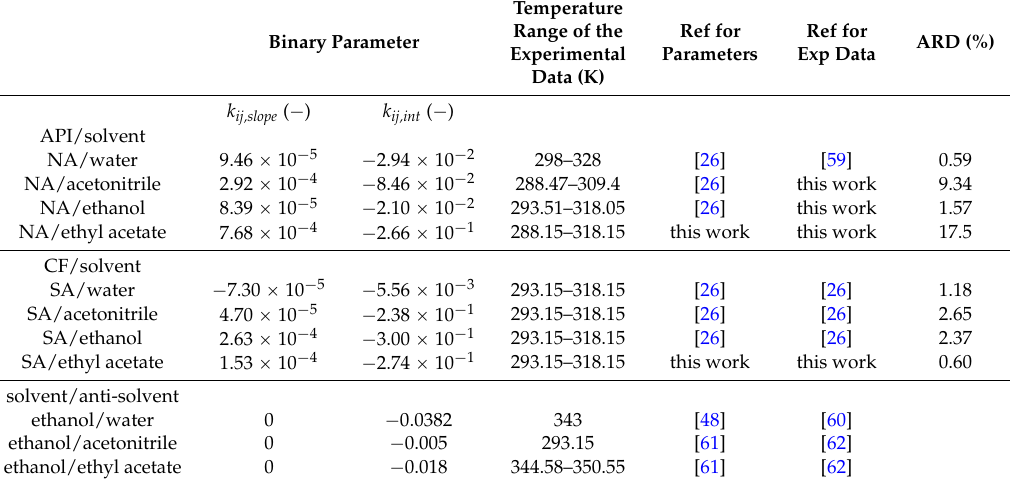
Table 4. PC-SAFT binary interaction parameters a for binary sub-systems considered in this work and average relative deviations (ARDs) of calculated and experimental solubilities. All other binary parameters were set to